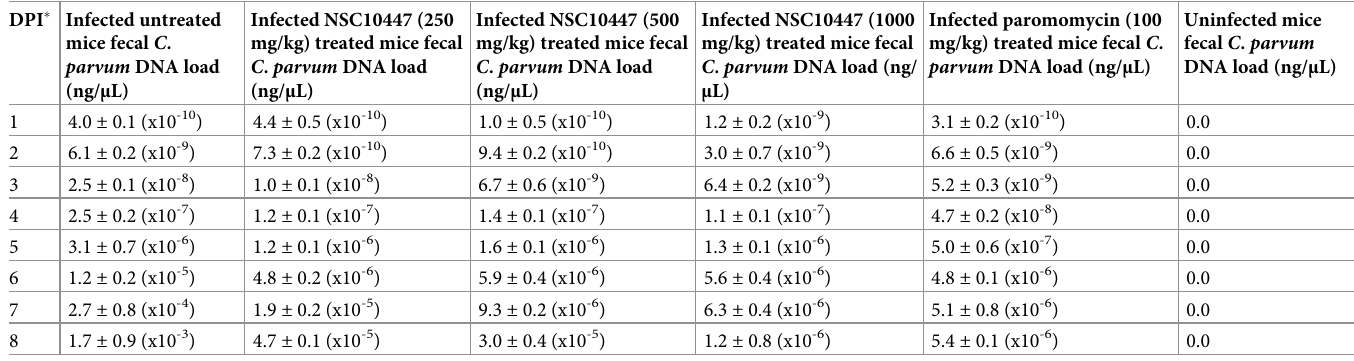
Table 6. Real-time PCR quantification of C . parvum DNA in fecal samples of treated or untreated infected mice. DPI � Infected untreated mice fecal C